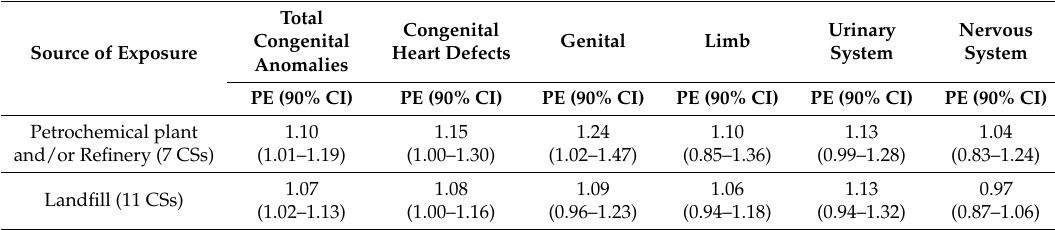
Table 3. Pooled estimate (PE) with 90% confidence interval (90% CI) by source of exposure and subgroup of congenital